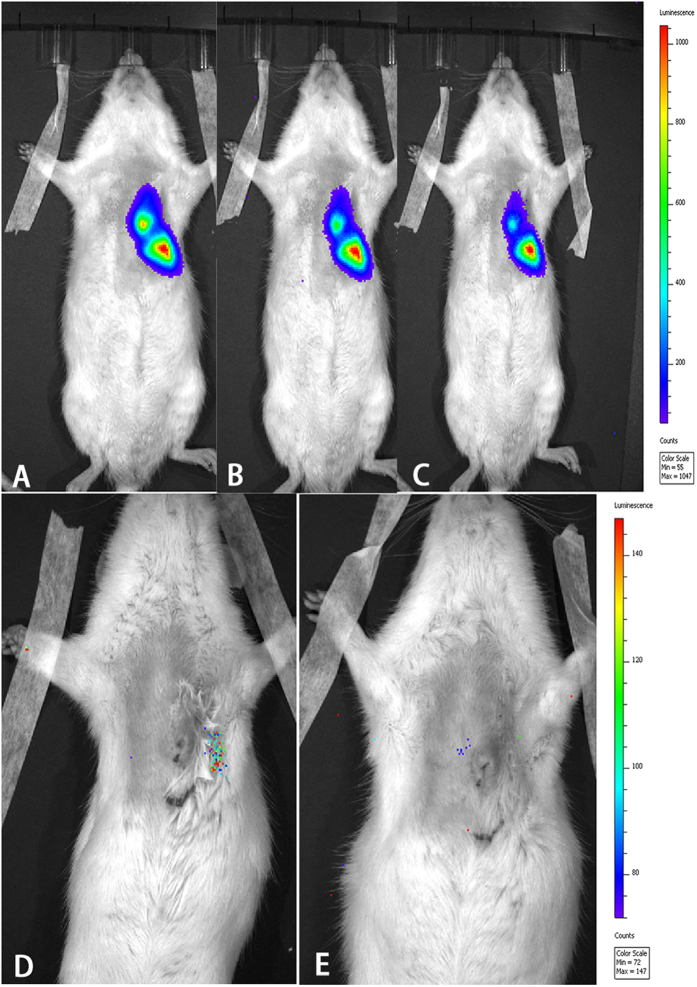
Bioluminescence imaging (BLI) dynamically monitored the survival status of the BMSCs.After intramyocardial injection, BLI was used to monitor the survival of transfected BMSCs in vivo. We found that transfected BMSC signals can be detected from 40 min (A) to 3 days (B), 5 day (C), and 7 days (D). However, the signals became undetectable after 9 days (E).